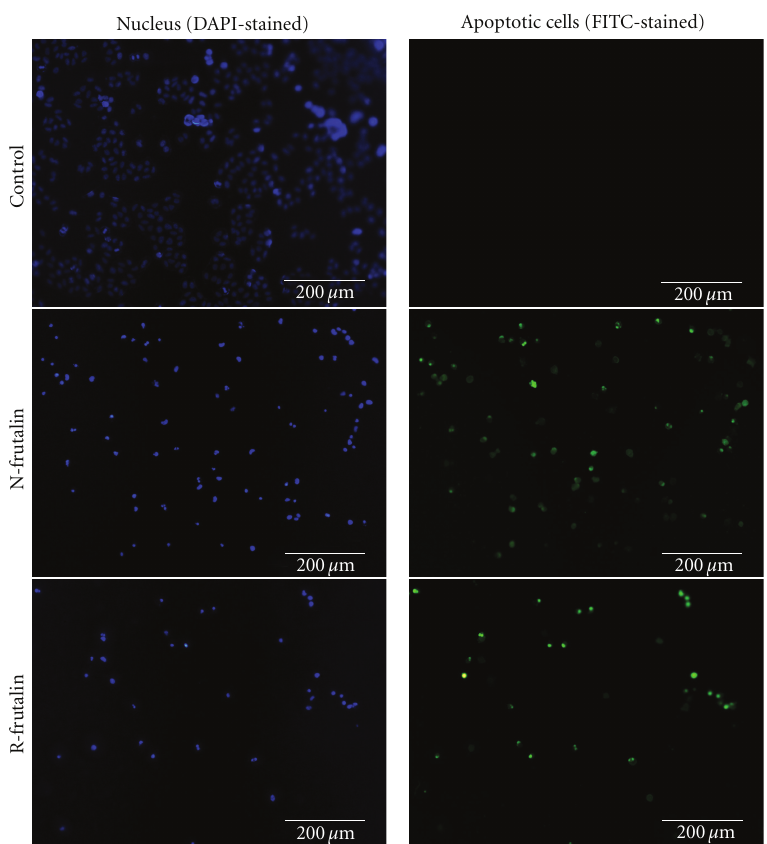
Figure 5: Apoptosis-inducing activity analysis by TUNEL assay. Fluorescence photographs of HeLa cells treated with n-frutalin and r-frutalin (both at 100 μ g/mL) for 24 h and analysed by TUNEL assay are shown. In the control, cells were incubated with PBS bu ff er instead of the lectins.